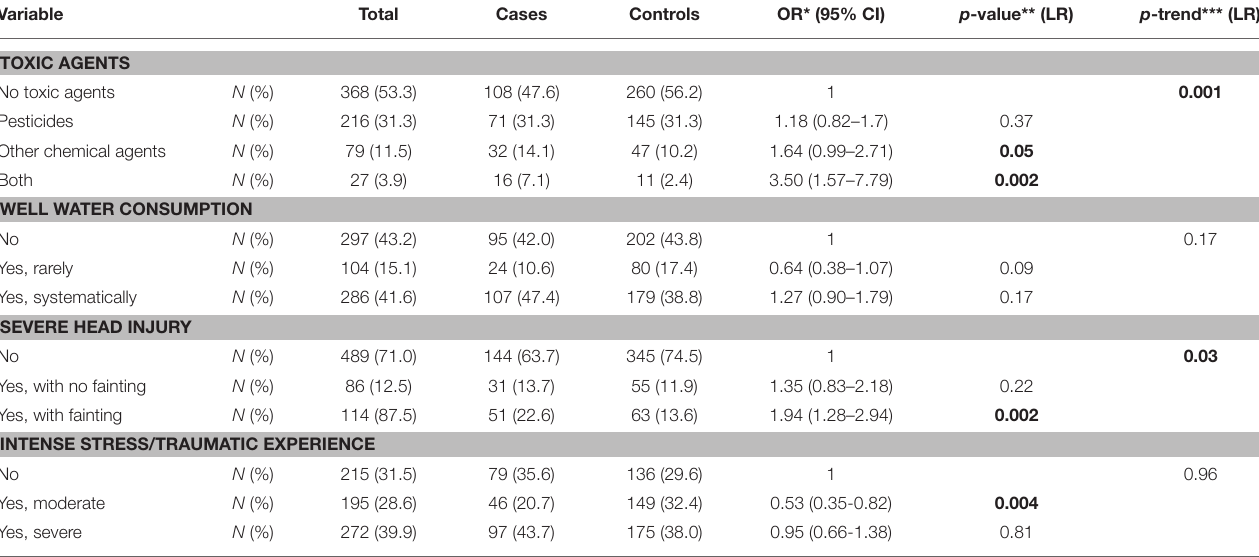
TABLE 3 | Previously reported exposure risk factors in Cypriot PD cases and controls. Variable